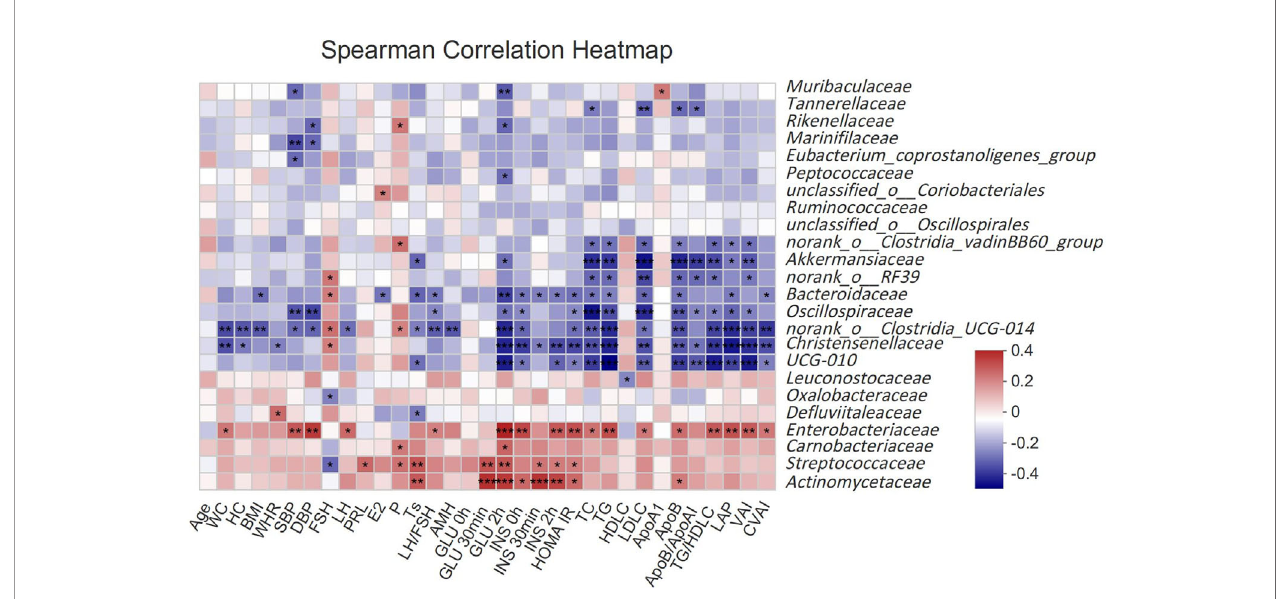
FIGURE 2 | Spearman correlation thermogram of clinical indicators and gut microbiota at Family level. Blue indicated a negative correlation and red indicated a positive correlation. The depth of the color represented the strength of the correlation. The deeper the color was, the stronger the correlation was. *P < 0.05, **P < 0.01, ***P <